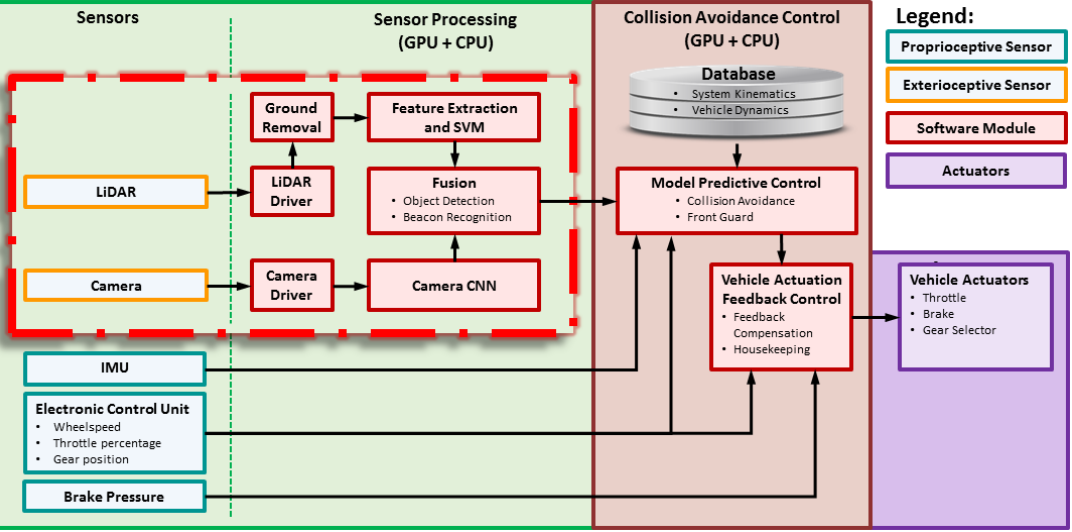
Figure 1. Collision avoidance system block diagram. IMU = inertial measurement unit. GPU = graphics processing unit. CPU = central processing unit. SVM = support vector machine. CNN = convolutional neural network. Figure best viewed in